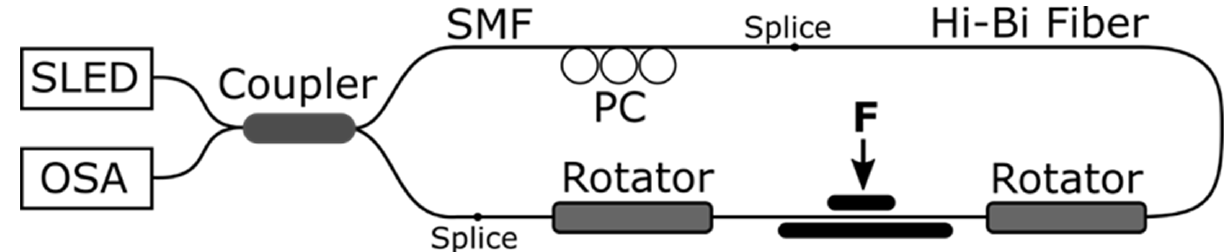
Figure 7. Set-up of a fiber optic Sagnac interferometer that has been applied for the corrosion monitoring of steel reinforce- ment bars [60].